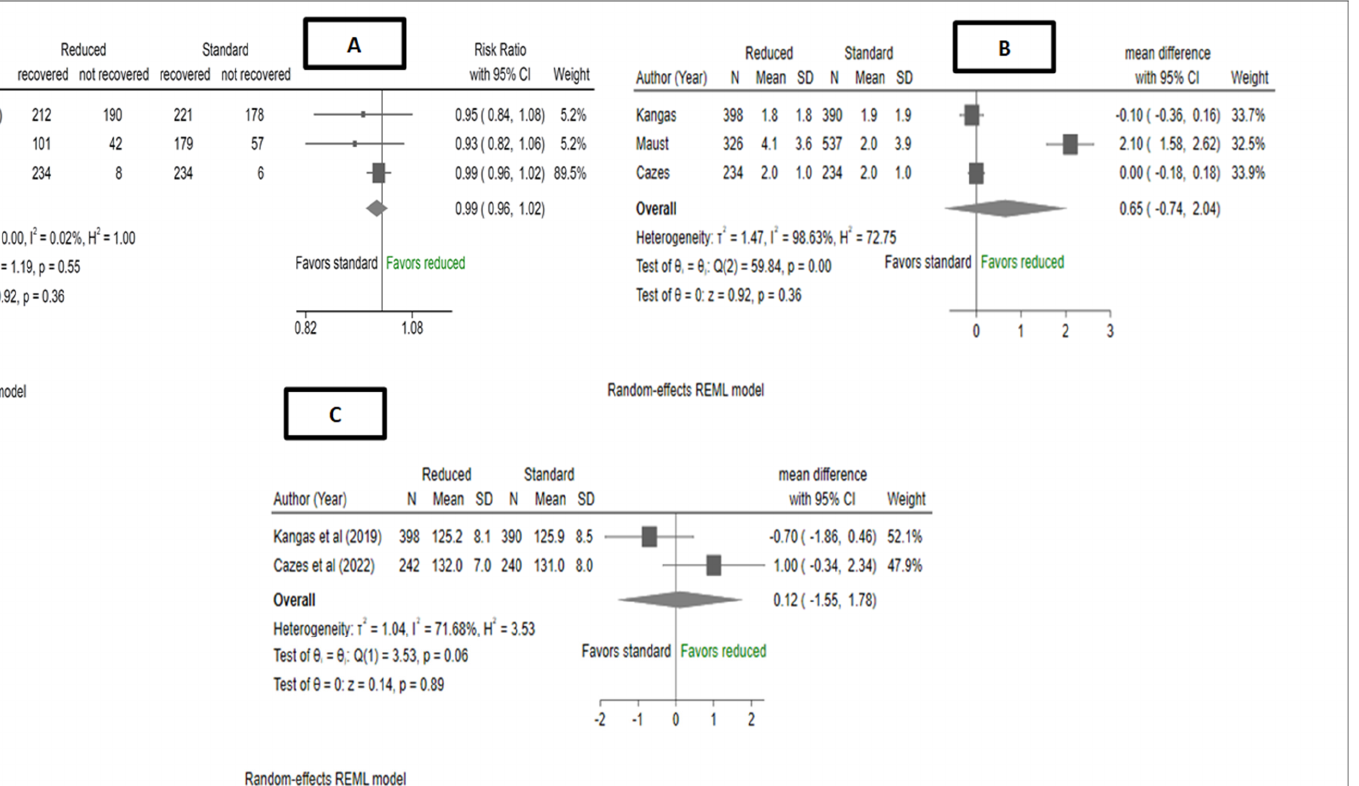
Figure 2. Forest plots of ( A ) anthropometric recovery rates, ( B ) weekly change in MUAC (from admission to discharge (Kangas et al., Maust et al. [12,13]) and at 6 months (Cazes et al. [14]) and ( C ) mean MUAC at discharge (Kangas et al. [12]) and 6 months (months (Cazes et al. [14]) from a meta-analysis of studies comparing reduced RUTF dose with standard RUTF dose for the treatment of severe wasting and/oedema. Effect estimates for Cazes et al. and Maust et al. (means and standard deviations) were obtained directly from the authors. Anthropometric recovery was assessed at 16 weeks for Kangas et al. and Cazes et al., whereas, for Maust et al., it was assessed at 12 weeks. Kangas et al. [12], defined anthropometric recovery as attaining either a WHZ of ≥− 2 or a MUAC of ≥ 125 mm or both on two consecutive visits and the absence of any illness. Cazes et al. [14] defined anthropometric recovery as MUAC of ≥ 125 mm in the reduced RUTF dose group and MUAC of ≥ 125 mm or WHZ score of ≥− 1.5 in the standard RUTF dose group. Maust et al. [13] defined anthropometric recovery as MUAC > 124 mm